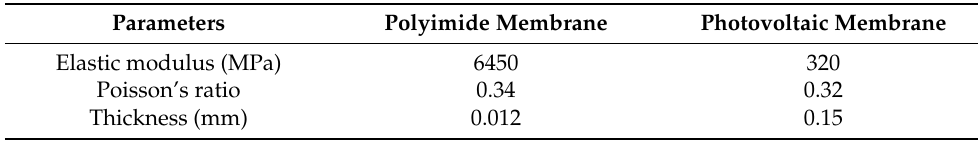
Table 2. The equivalent mechanical properties of the membranes.